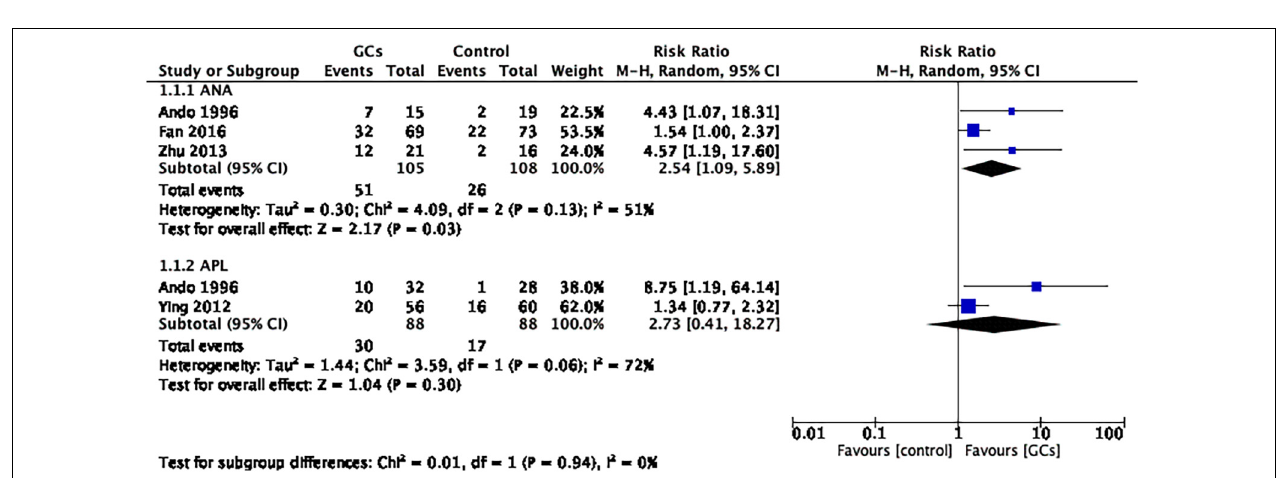
FIGURE 2 | Forrest plot for comparison: glucocorticoids versus no glucocorticoids/placebo, outcome: I. I Clinical pregnancy rate per couple. Six studies reported the clinical pregnancy rate per couple. This result favors glucocorticoid use in improving the clinical pregnancy rate (RR 2.19, 95% CI 1.64 –2.92, p < 0.00001, six cohort studies, 479 women, I 2 = 39%).